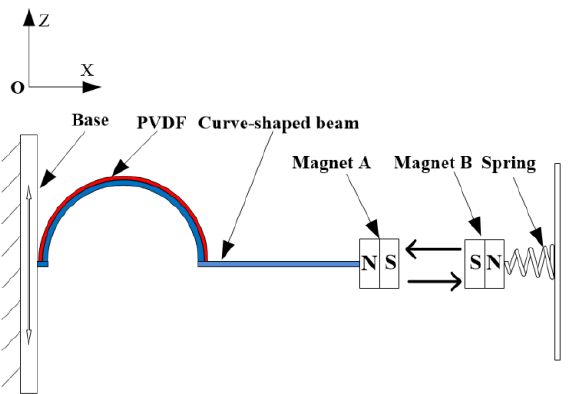
Figure 4. Schematic diagram of the BPEH-V.